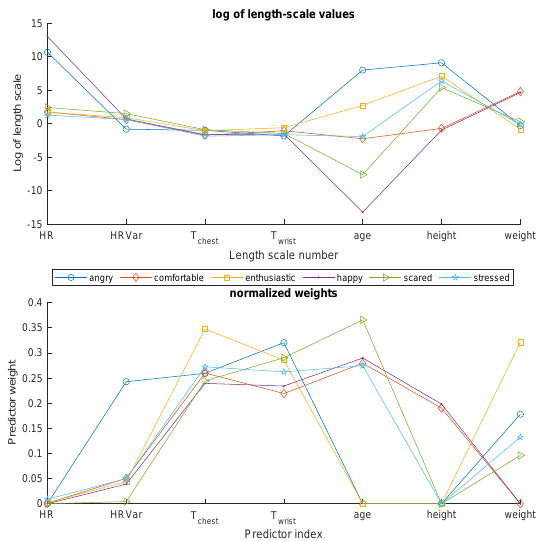
Figure 7. OAD length scale parameters (log values) and parameter weights for the data set without